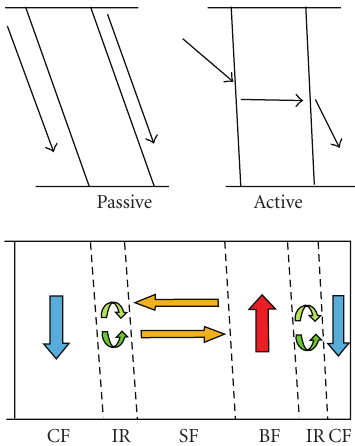
Figure 1: Di ff erent cell structures (CF: clean flow, IR: interface region, SF: stalled flow, and BF: back